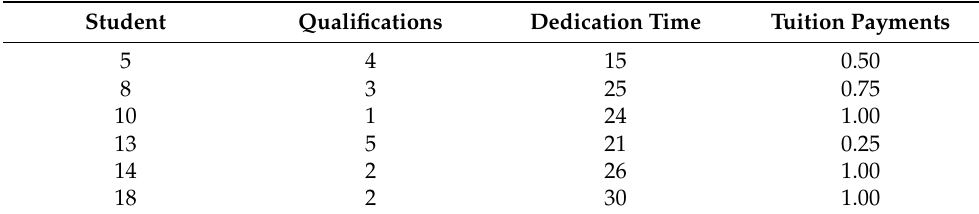
Table 2. Students who failed the subject of Programming I, identification of the causes of their low performance.